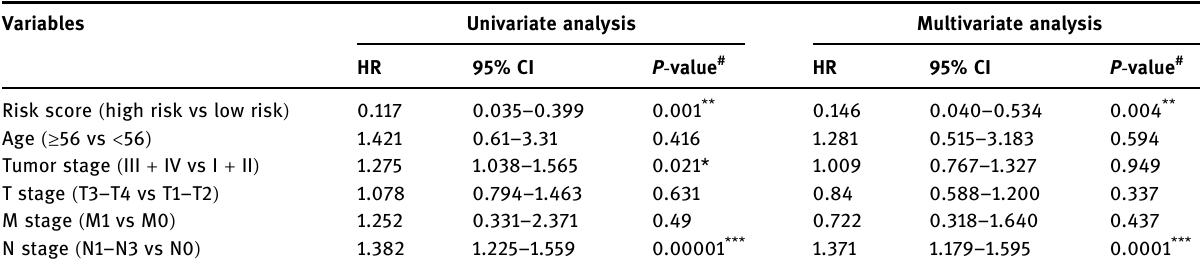
Table 1: Univariate analysis and multivariate analysis of prognostic factors